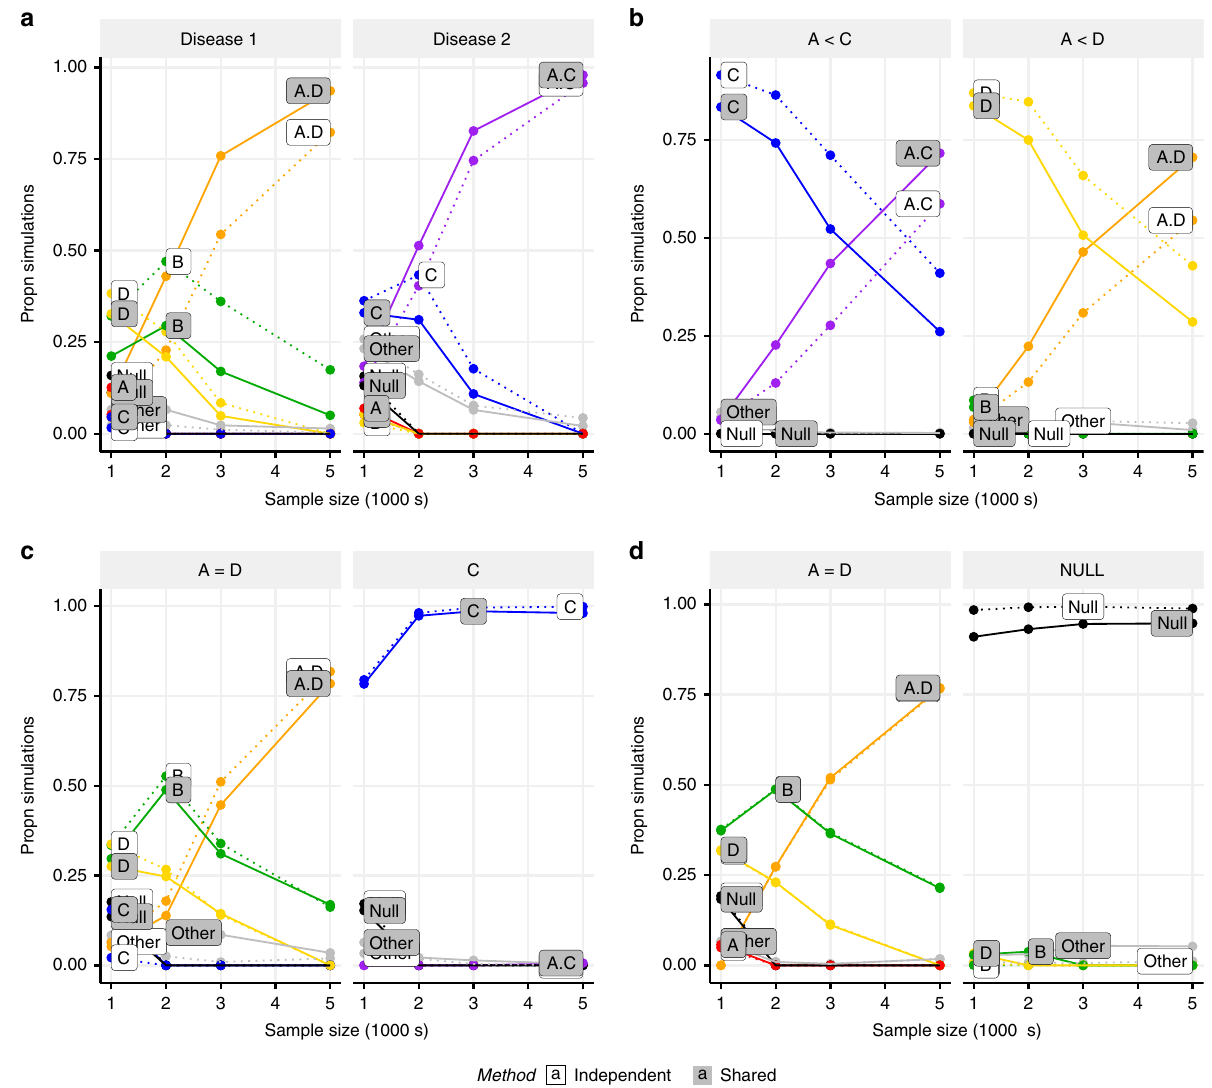
Fig. 4 Comparison of MFM analysis and single disease analysis. Causal variants were simulated for two diseases with models de fi ned by SNP groups from the IL2RA region. MFM is shown by solid lines and independent analyses by dashed lines. Throughout, disease 1 has causal variants A + D, while causal variants for disease 2 vary. a, b Disease 2 has causal variants A + C and the odds ratio of A, OR A , is the same for both diseases; a A has a stronger effect than C and D; OR A = 1.4 (both), OR D = 1.25 (disease 1), OR C = 1.25 (disease 2). b A has a weaker effect than C and D; OR A = 1.25 (both), OR D = 1.4 (disease 1), OR C = 1.4 (disease 2). c Disease 2 has only C causal; OR A = OR D = 1.25 (disease 1), OR C = 1.25 (disease 2). d Disease 2 has no causal variants (no association). Potential models include A (red), B (green), C (blue), D (yellow), A + D (orange), A + C (purple) and null (black); any other models are grouped together as grey. The y -axis shows the average posterior probabilities for each model. a, b MFM can identify the true two causal variant model at smaller sample sizes than independent analysis in simulated data when there is sharing between diseases. c, d When there is no sharing ( c ) or one disease has no true associations ( d ), no information is gained by using MFM but there is only minimal loss in accuracy in doing so. Source data are provided